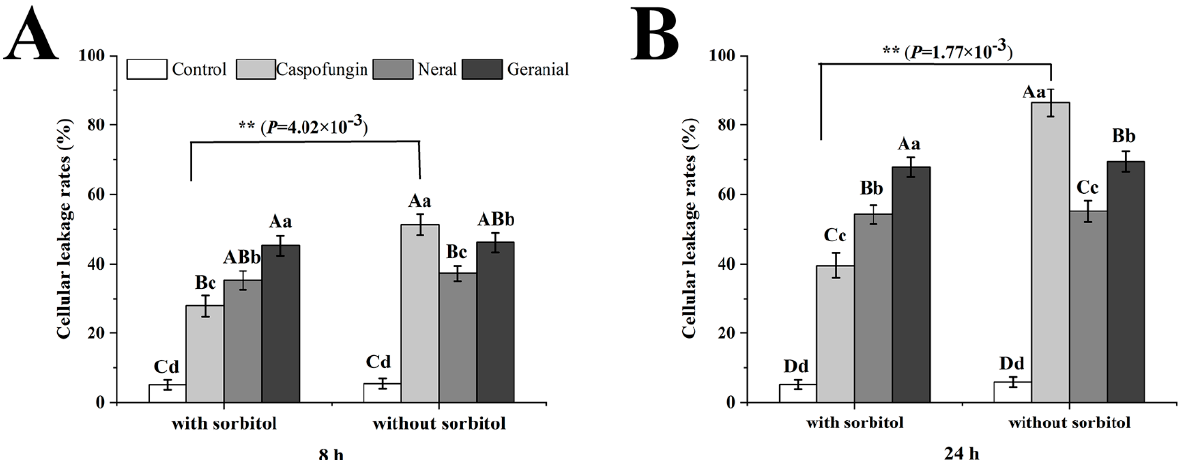
Figure 3. Cellular leakage rates of Trichophyton rubrum conidia treated with specific agents at minimum inhibitory concentration for 8 h ( A ) and 24 h ( B ). Within the minimum fungicidal concentration (MFC) CA and same time intervals, “**” indicates a significant difference ( p < 0.01) between those with sorbitol and without sorbitol; within the same medium (with sorbitol or without sorbitol) and time intervals, columns with lowercase or uppercase letters indicate significant or highly significant differences ( p < 0.05 or p < 0.01).